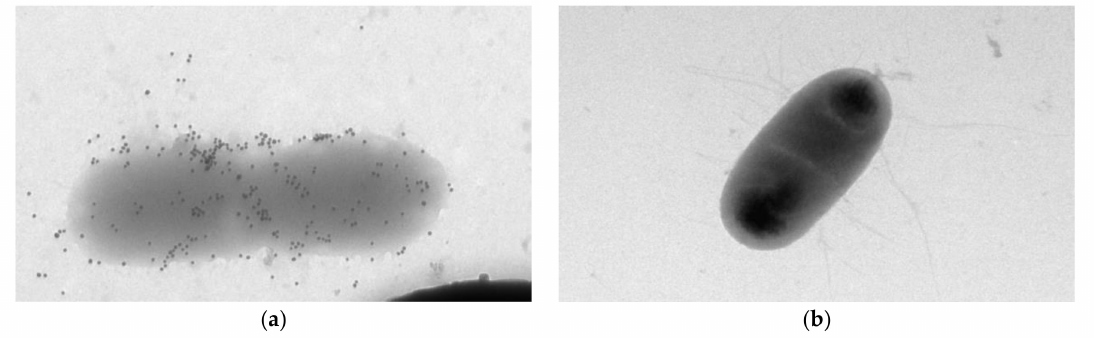
Figure 6. Electron microscopy of ( a ) cells of A. brasilense Sp7 with Abs specific to A. brasilense Sp7 labeled with colloidal gold ( × 10,000) and ( b ) E. coli K-12 with Abs specific to A. brasilense Sp7.